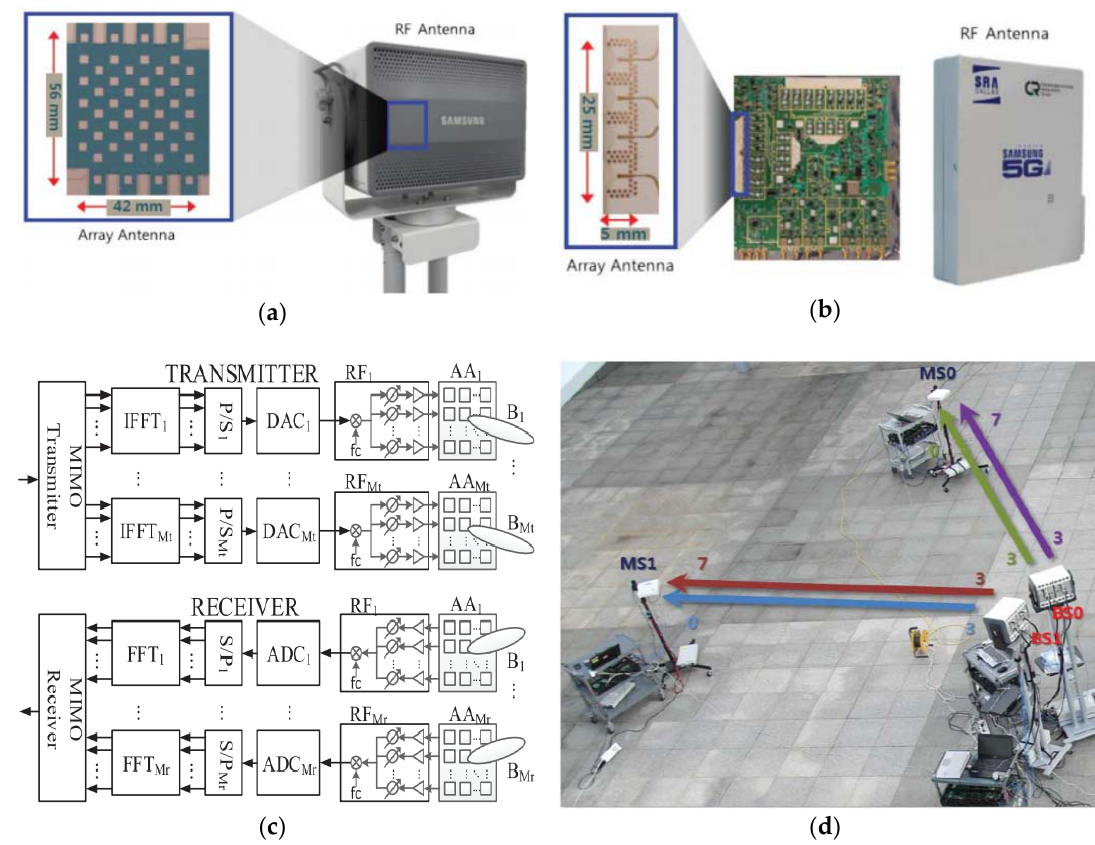
Figure 16. ( a ) Transceiver array antenna for BS. ( b ) Transceiver array antenna for MS. ( c ) Block diagram of testbed for mm-wave cellular communication with beamforming antenna array. ( d ) Testbed structure built at Samsung Electronics, Korea. (Redrawn from [13])